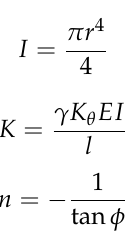
Figure 10. Pseudo-rigid-body model.